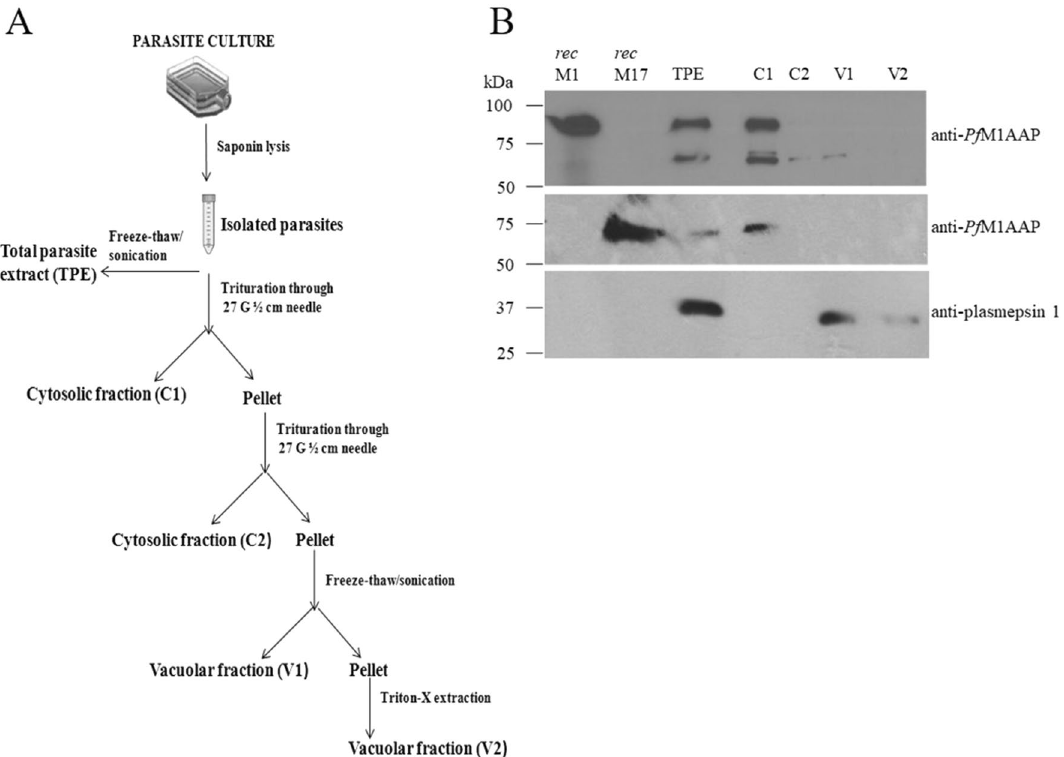
Figure 1. Distribution of Pf M1AAP and Pf M17LAP in the P. falciparum cellular compartments. ( A ) Flowchart depicting the isolation of P. falciparum parasites from host erythrocytes followed by fractionation of cell compartments. Parasites were isolated by saponin lysis of erythrocytes. Total parasite extracts (TPE) were prepared by freeze–thaw and sonication of the parasites in 10 mM Tris–HCl buffer, pH 7.2. Other samples were triturated four times through a syringe needle and centrifuged to obtain the first cytosolic fraction, C1, and a pellet. The pellet was resuspended in 10 mM Tris–HCl buffer, pH 7.2 and triturated/centrifuged to obtain the second cytosolic fraction, C2, and a pellet. This pellet was re-suspended in 10 mM Tris–HCl buffer, pH 7.2, and subjected to four rounds of freeze–thaw treatment followed by centrifugation to obtain a soluble vacuolar fraction, V1, and a pellet. The final detergent-soluble vacuolar fraction, V2, was obtained by incubating the pellet in 0.5% Triton X for 30 min on ice. ( B ) Representative immunoblots of three biological replicates showing the P. falciparum recombinant (rec) Pf M1AAP, rec Pf M17LAP, total parasite extract (TPE) and cellular fractions (C1, C2, V1 and V2) probed with anti- Pf M1AAP (top panel), anti- Pf M17LAP (middle panel), and anti-